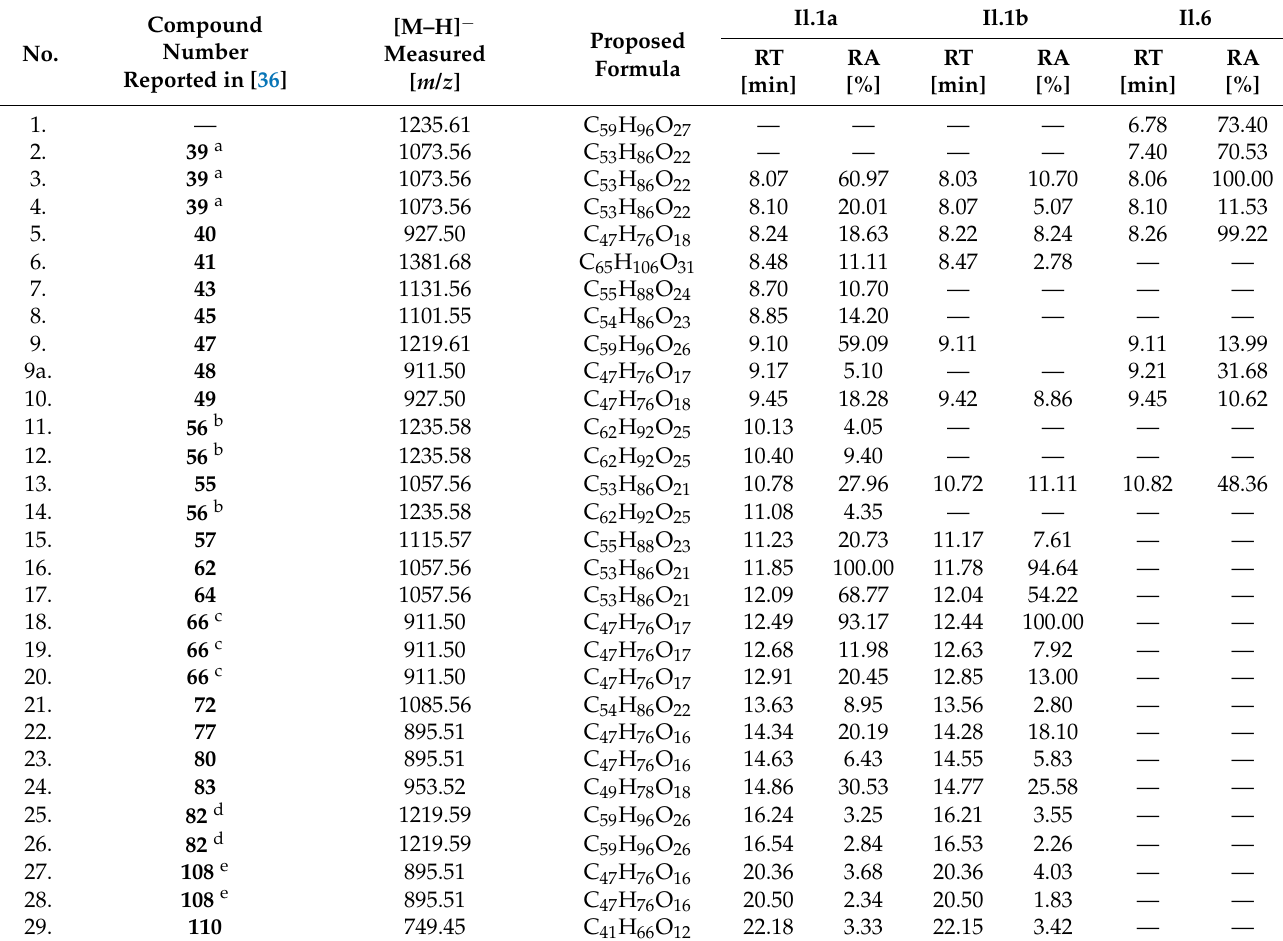
Table A2. UHPLC-ESI-MS comparison of main saponin profiles of I. meserveae saponin-rich fraction (Il.6) and reference commercial Mate samples (Il.1a and Il.1b).